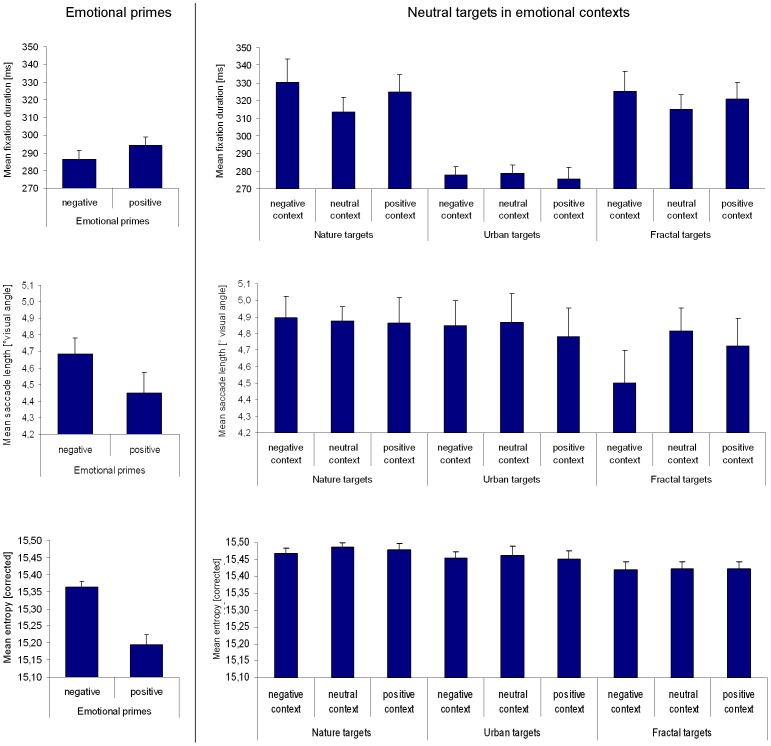
Eye-movement parameters on emotion-laden and neutral images.Eye-movement parameters on negative and positive IAPS images serving as emotion-laden primes (left side) and parameters on neutral target images (nature, urban, and fractal) depending on target type and emotional context in which target images were embedded (right side). Vertical lines above bars indicate standard error of the mean. Note: The axis of ordinates differs between primes and targets with respect to the scaling. Moreover, the experimental setups of Studies 1 and 2 were identical, and therefore, absolute parameter values are comparable between both studies.